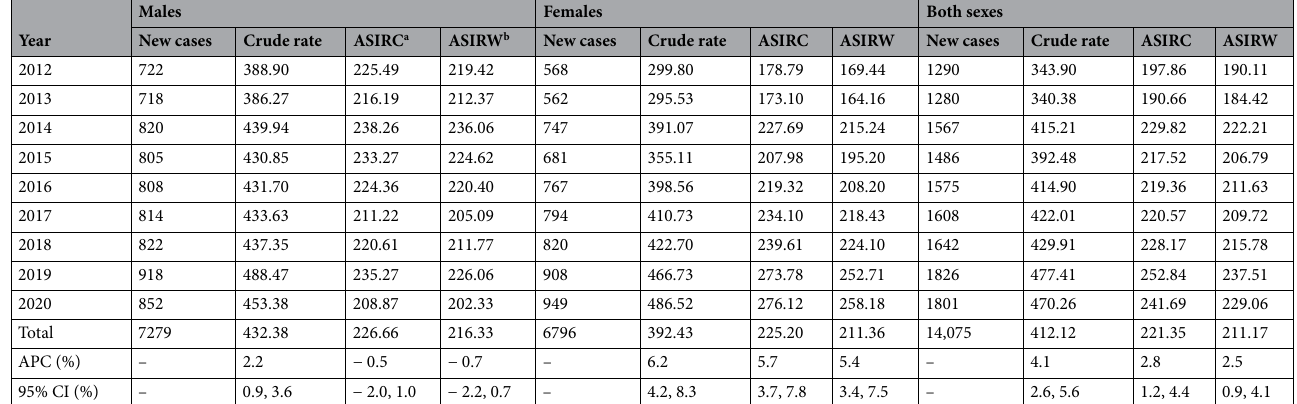
Table 9. Cancer incidence around Qinshan NPP from 2012 to 2020(1/100,000). a Age-standardized incidence rate by Chinese 2000 standard population. b Age-standardized incidence rate by WHO 2000 standard